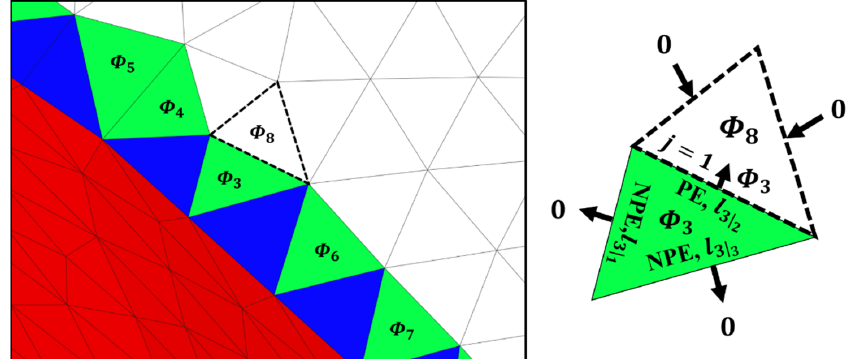
Figure 12. Example case of further propagation.